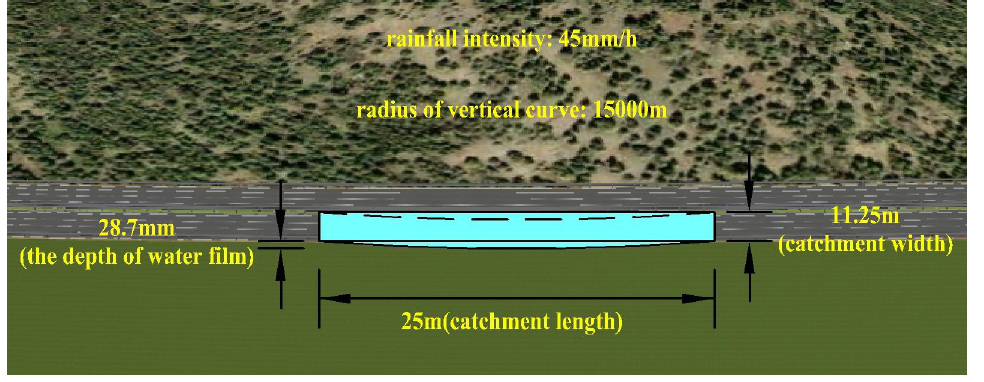
Fig 12. Schematic of the water film depth (Model